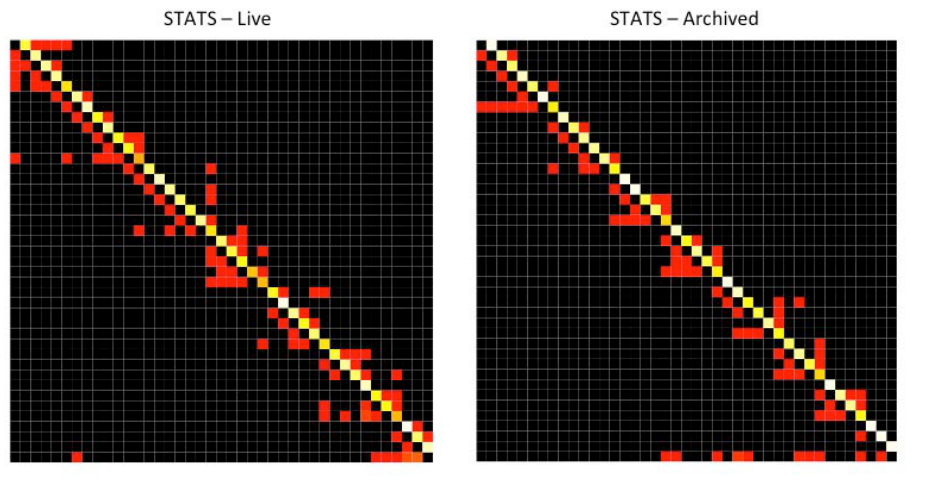
Figure 4. Video transition matrices for STATS, intent category most.